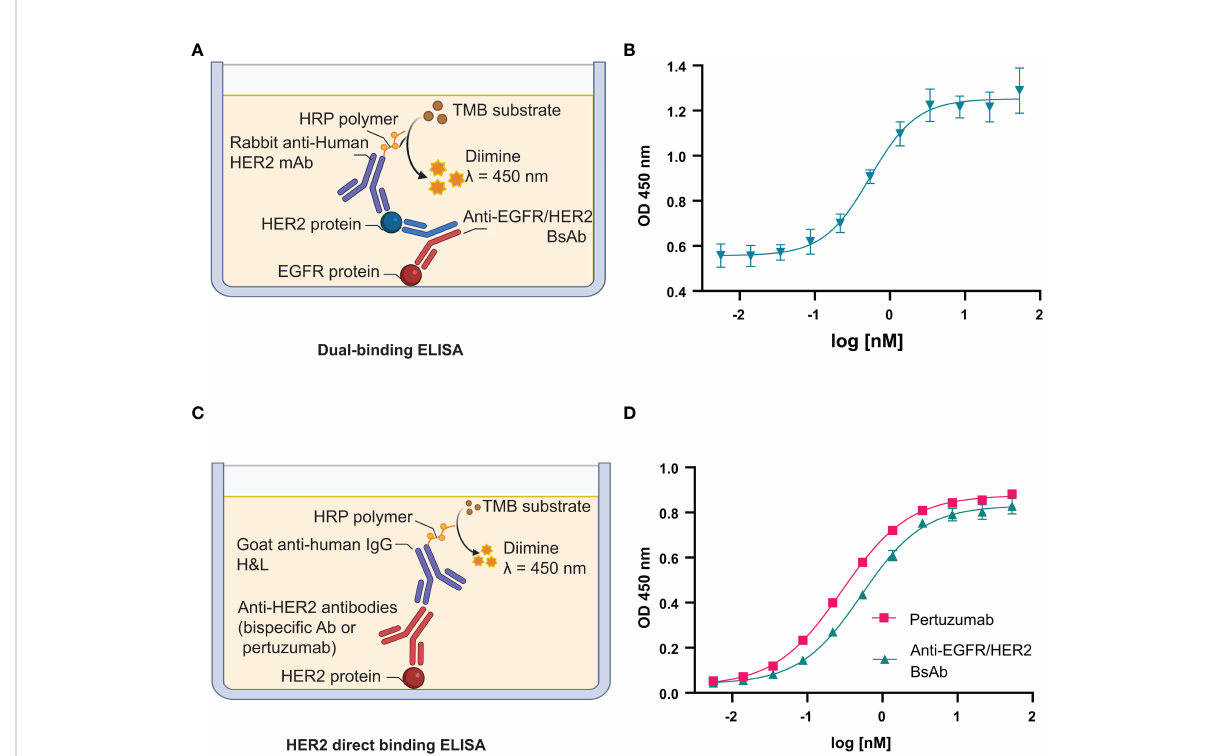
FIGURE 8 Fab binding activity of anti-EGFR/HER2 BsAb. (A) Schema of dual-binding ELISA format that was used in this study. (B) The anti-EGFR/HER2 BsAb shows dose-dependent binding consistent with its proposed quaternary structure. (C) Schema of direct HER2 binding ELISA. (D) The binding af fi nity of BsAb was compared to pertuzumab.The error bars indicate standard deviation from three independent experiments. Graphs were generated using GraphPad Prism version 8.4.3 for